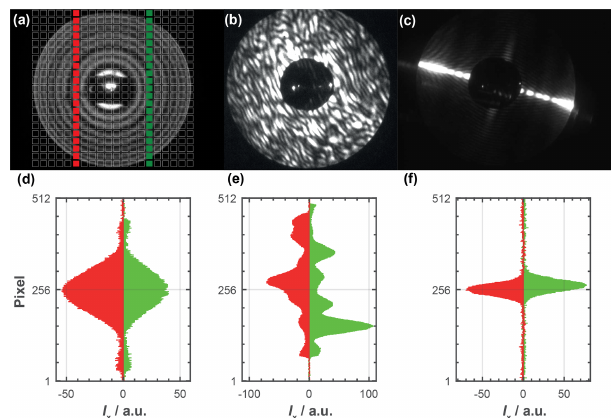
Figure 2. (a–c) : Example 2-D scattering patterns captured by SID3 (Ulanowski et al., 2014), showing (a) a cloud droplet, (b) an ice crystal and (c) a columnar ice crystal. The forward scattering pat- tern of the cloud droplet reveals rotational symmetry, while those of the ice crystal and the fiber do not. The pixels of the CCD camera are schematically indicated by the gray squares on top of panel (a) . The reduced information captured by the linear CMOS arrays of PPD-HS is highlighted by the red (array 1) and green (array 2) squares, respectively. Panels (d) – (f) show scattering data from the linear CMOS arrays, showing relative forward-scattered light inten- sity for the individual pixels comprising an array for (d) a spherical particle, (e) an aspherical particle and (f) a fiber-like particle. Im- ages (a) – (c) provided by Chris Stopford. Please see figures below for further scattering patterns. Scattering patterns of spherical par- ticles, where multiple diffraction fringes are detected by the linear CMOS arrays can be found in, for example, Supplement Fig.